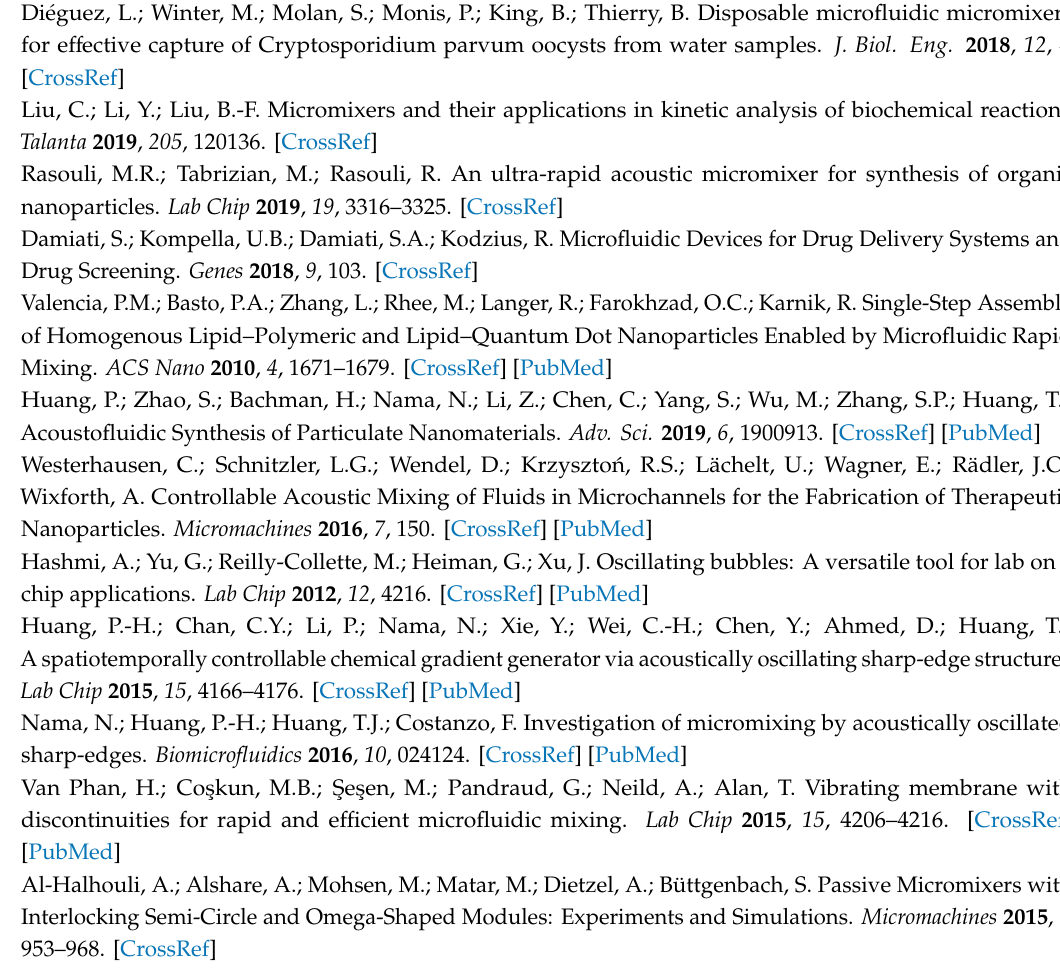
s1, Figure S1: Image of the lab-made clamp used to adjust the exerted force on the microchips during the fabrication